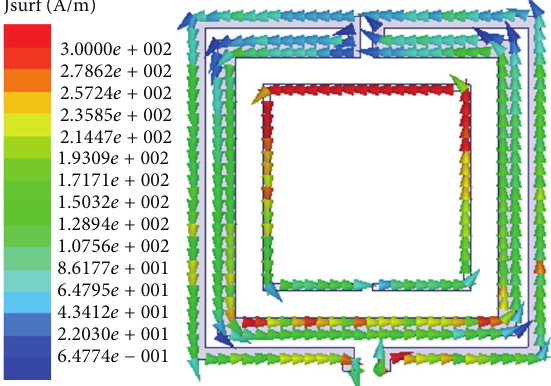
Figure 3: Antenna surface current distribution.